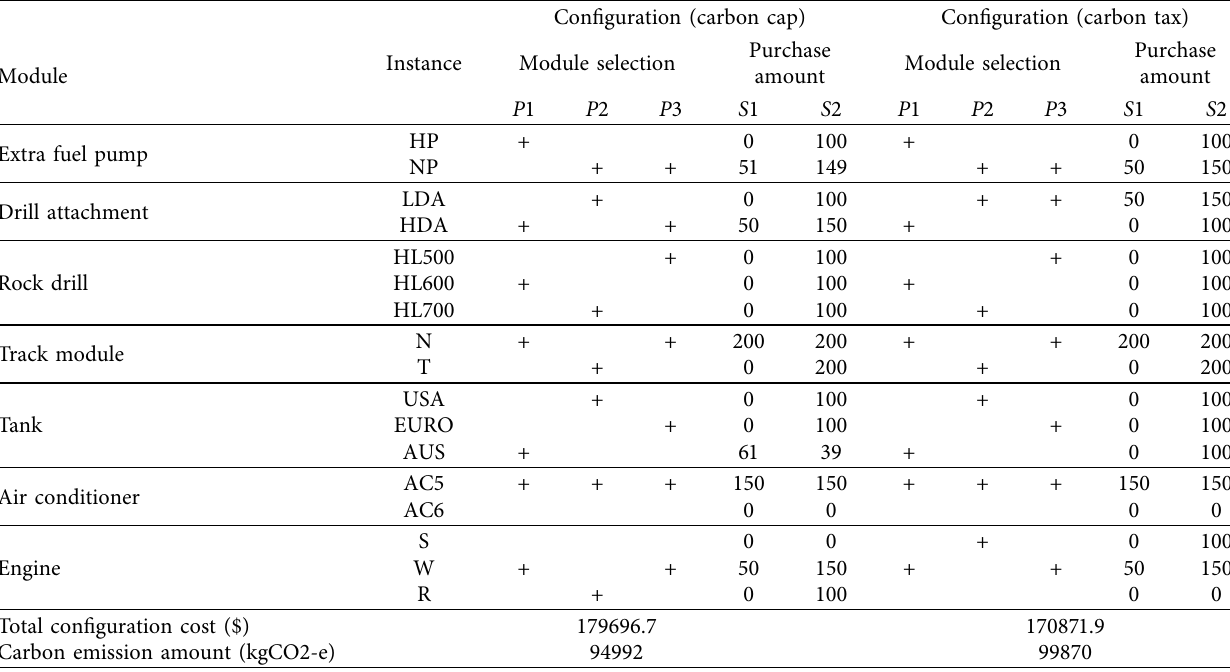
Table 5: Configuration results.